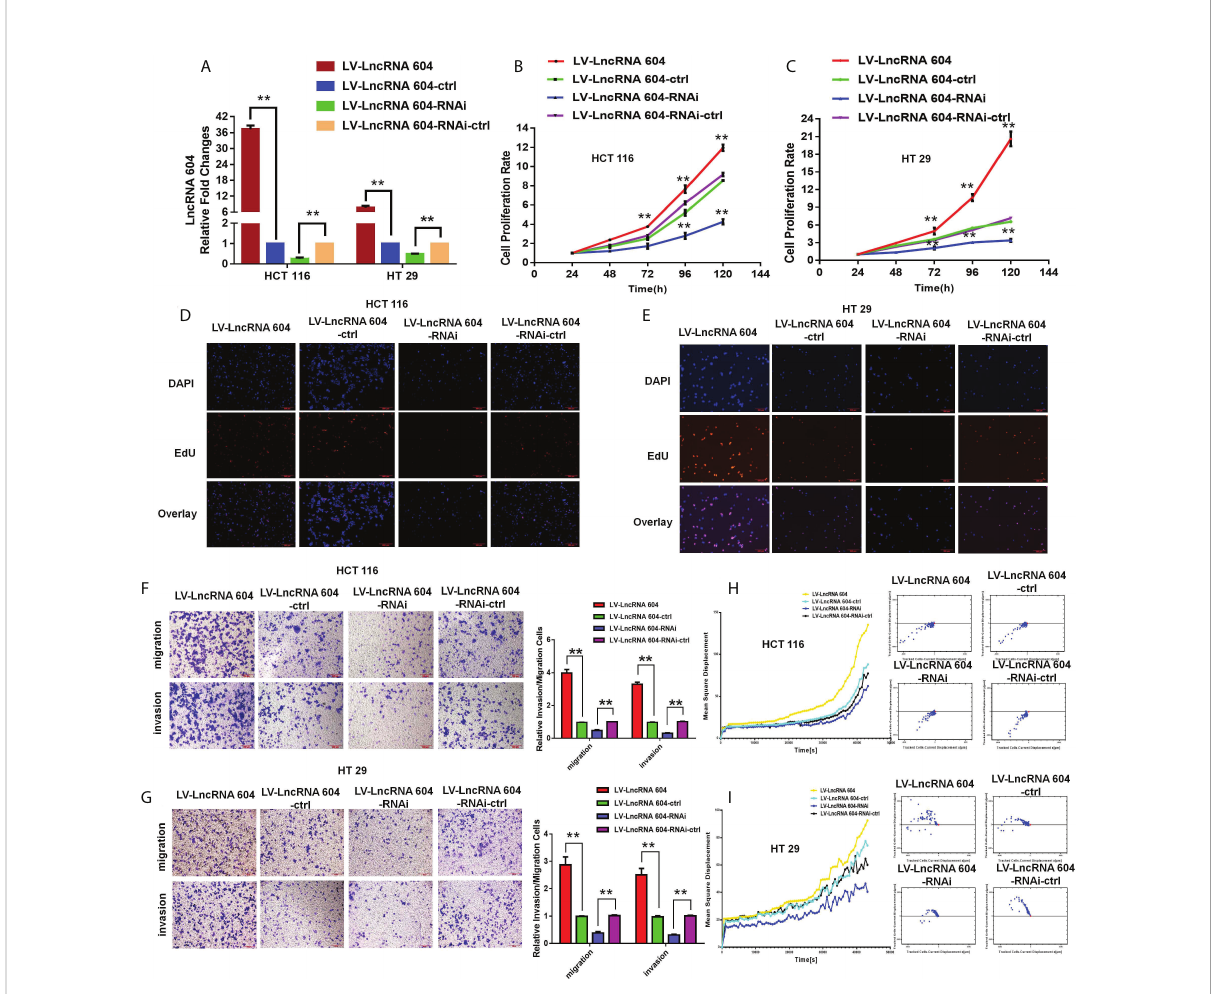
FIGURE 2 LncRNA 604 promoted CRC cells proliferation and metastasis in vitro. (A) The effect of virus interference for lncRNA 604, the experimental cells were divided into four groups: LV-LncRNA 604; LV-LncRNA 604-ctrl; LV-LncRNA 604-RNAi; LV-LncRNA 604-RNAi-ctrl. (B, C) LncRNA 604 could promote CRC cells proliferation by CCK8 assay [ (B) HCT 116; C: HT 29]. (D, E) LncRNA 604 could promote CRC cells proliferation by EDU assay [ (D) HCT 116; (E) HT 29]. (F, H) LncRNA 604 could enhance CRC cells invasion and migration by transwell assay [ (F) HCT 116; (H) HT 29]. (G, I) LncRNA 604 could enhance CRC cells invasion and migration by high-content imaging system analysis [ (G) HCT 116; (I) HT 29]. All ** P <